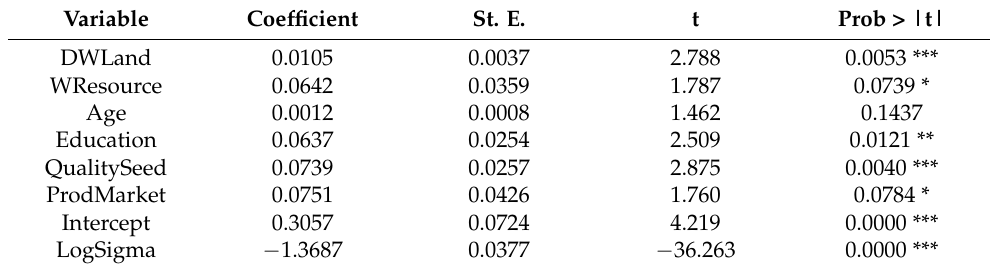
Table 7. Results of the Tobit Model.